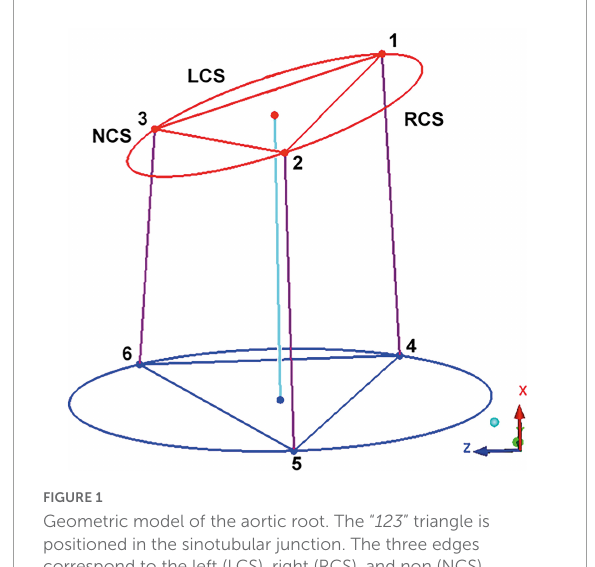
FIGURE1 Geometric model of the aortic root. The “ 123 ” triangle is positioned in the sinotubular junction. The three edges correspond to the left (LCS), right (RCS), and non (NCS) coronary sinus commissures. The triangle at the aortic root base is marked by the “ 456 ” triangle, the basal points correspond to the vertical projection of the three commissures into the root base. By interconnecting the points of both triangles, a model of the aortic root is obtained. This model is a prism where the basal and the sinotubular junction plane are not parallel. The axe of the prism interconnect the center of the sinotubular junction and aortic root base. LCS, left coronary sinus; RCS, right coronary sinus; NCS, non-coronary sinus. Adapted from